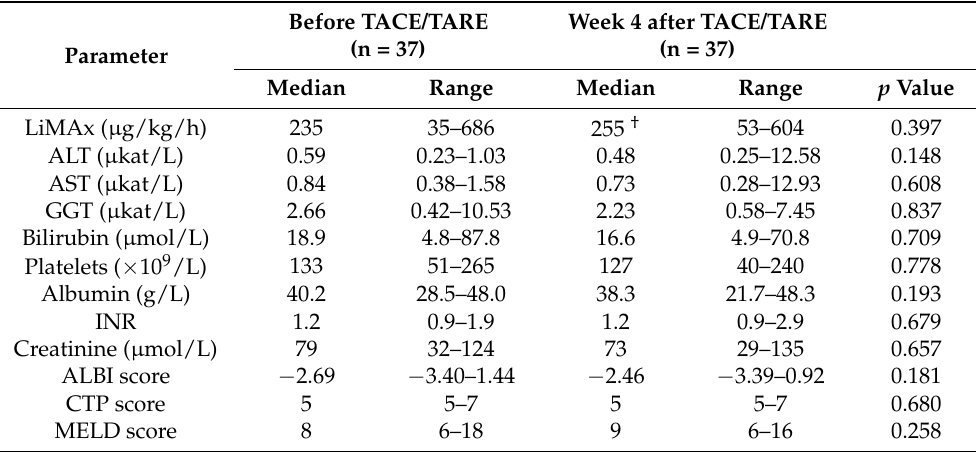
Figure 2. Correlation of ( A ) baseline LiMAx levels with MELD and ALBI scores and ( B ) baseline LiMAx levels with serum bilirubin and albumin before treatment (day 0) and after treatment (week 4), of ( C ) baseline LiMAx with LiMAx levels at week 4 and of LiMAx levels with ( D ) MELD and ALBI score and ( E ) bilirubin and albumin at week 4. ALBI: albumin–bilirubin, LiMAx: liver maximum function test MELD: model for end-stage liver disease. Table 2. LiMAx results, laboratory parameters, and liver function scores before and at week 4 after transarterial